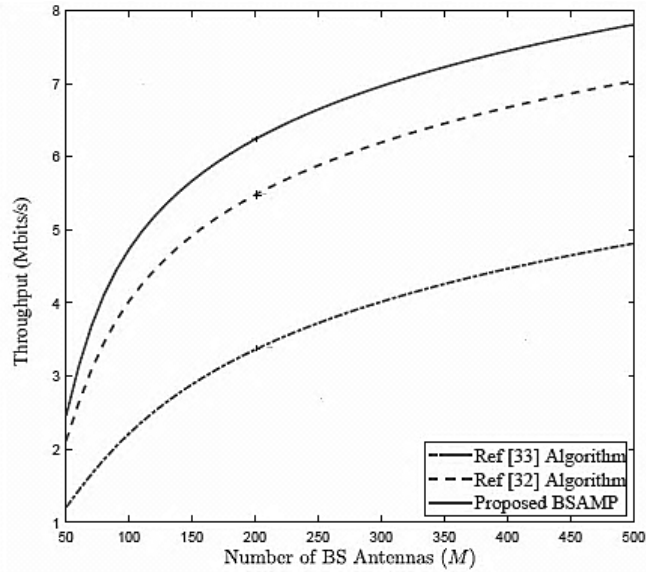
Figure 3. Throughput comparison of each algorithm with increasing number of antennas.